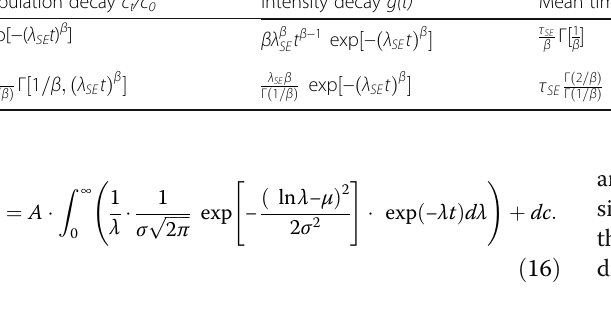
Table 1 Formulas for stretched exponential population and luminescence decays. The approximate solution H ( λ ) is shown in ref. [9] Population decay c t /c 0